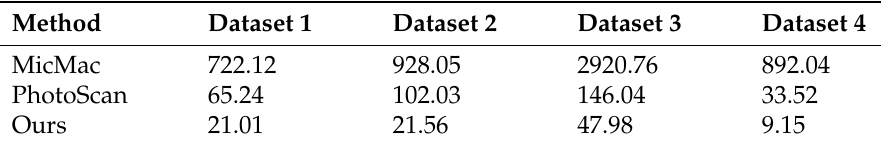
Table 7. Time costs in feature matching for the four datasets (in